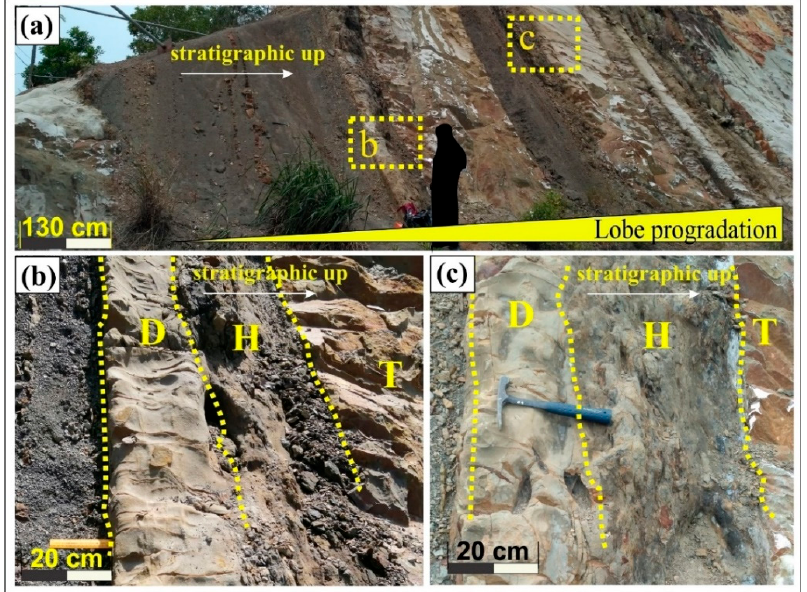
Figure 10. Relative position of hybrid beds in lobe progradation. ( a ) A thickening upward cycle in the Universiti Prima Condo (UP) section, West Sabah, where the vertical thickness of a massive shale is gradually reduced from base to top. Shaded image of a 173 cm tall person is shown as a vertical scale. ( b ) Massive shale overlain by debrite (D), hybrid event bed (H), and then massive sandy turbidite (T) present in the lower part of prograding lobe. ( c ) A second hybrid event bed (H) between debrite (D) and turbidite (T) is present in lobe progradation.